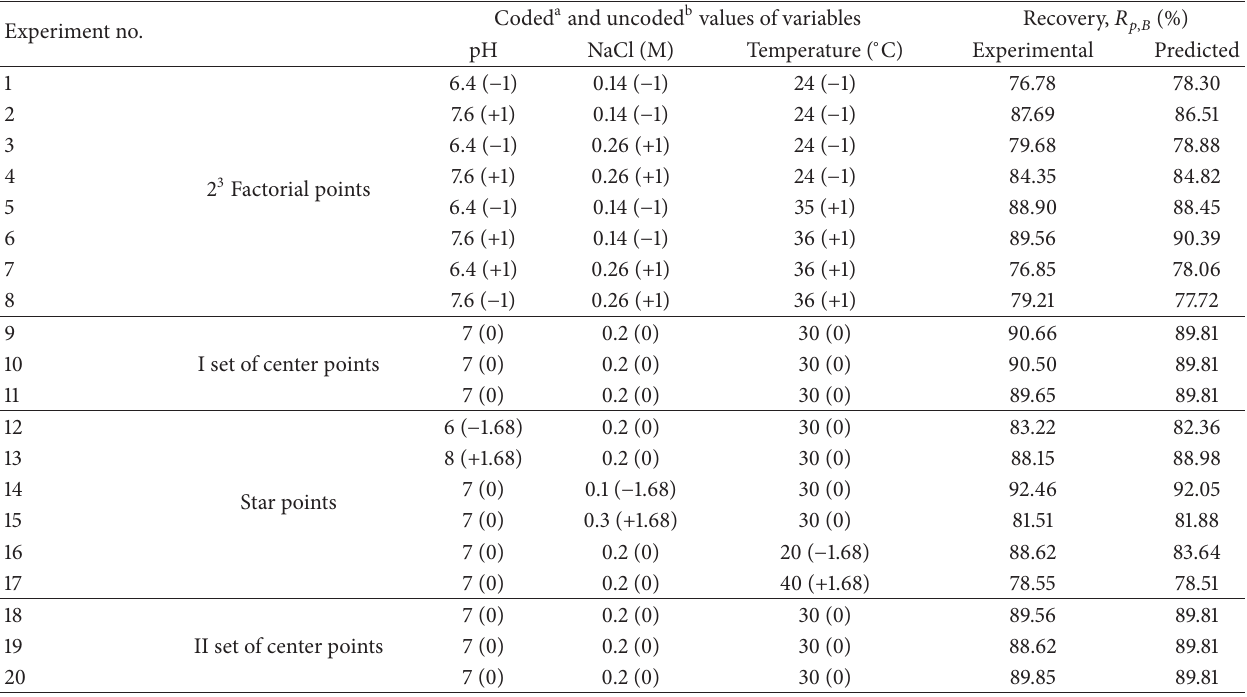
Table 2: Central composite design (CCD) of variables with % recovery as